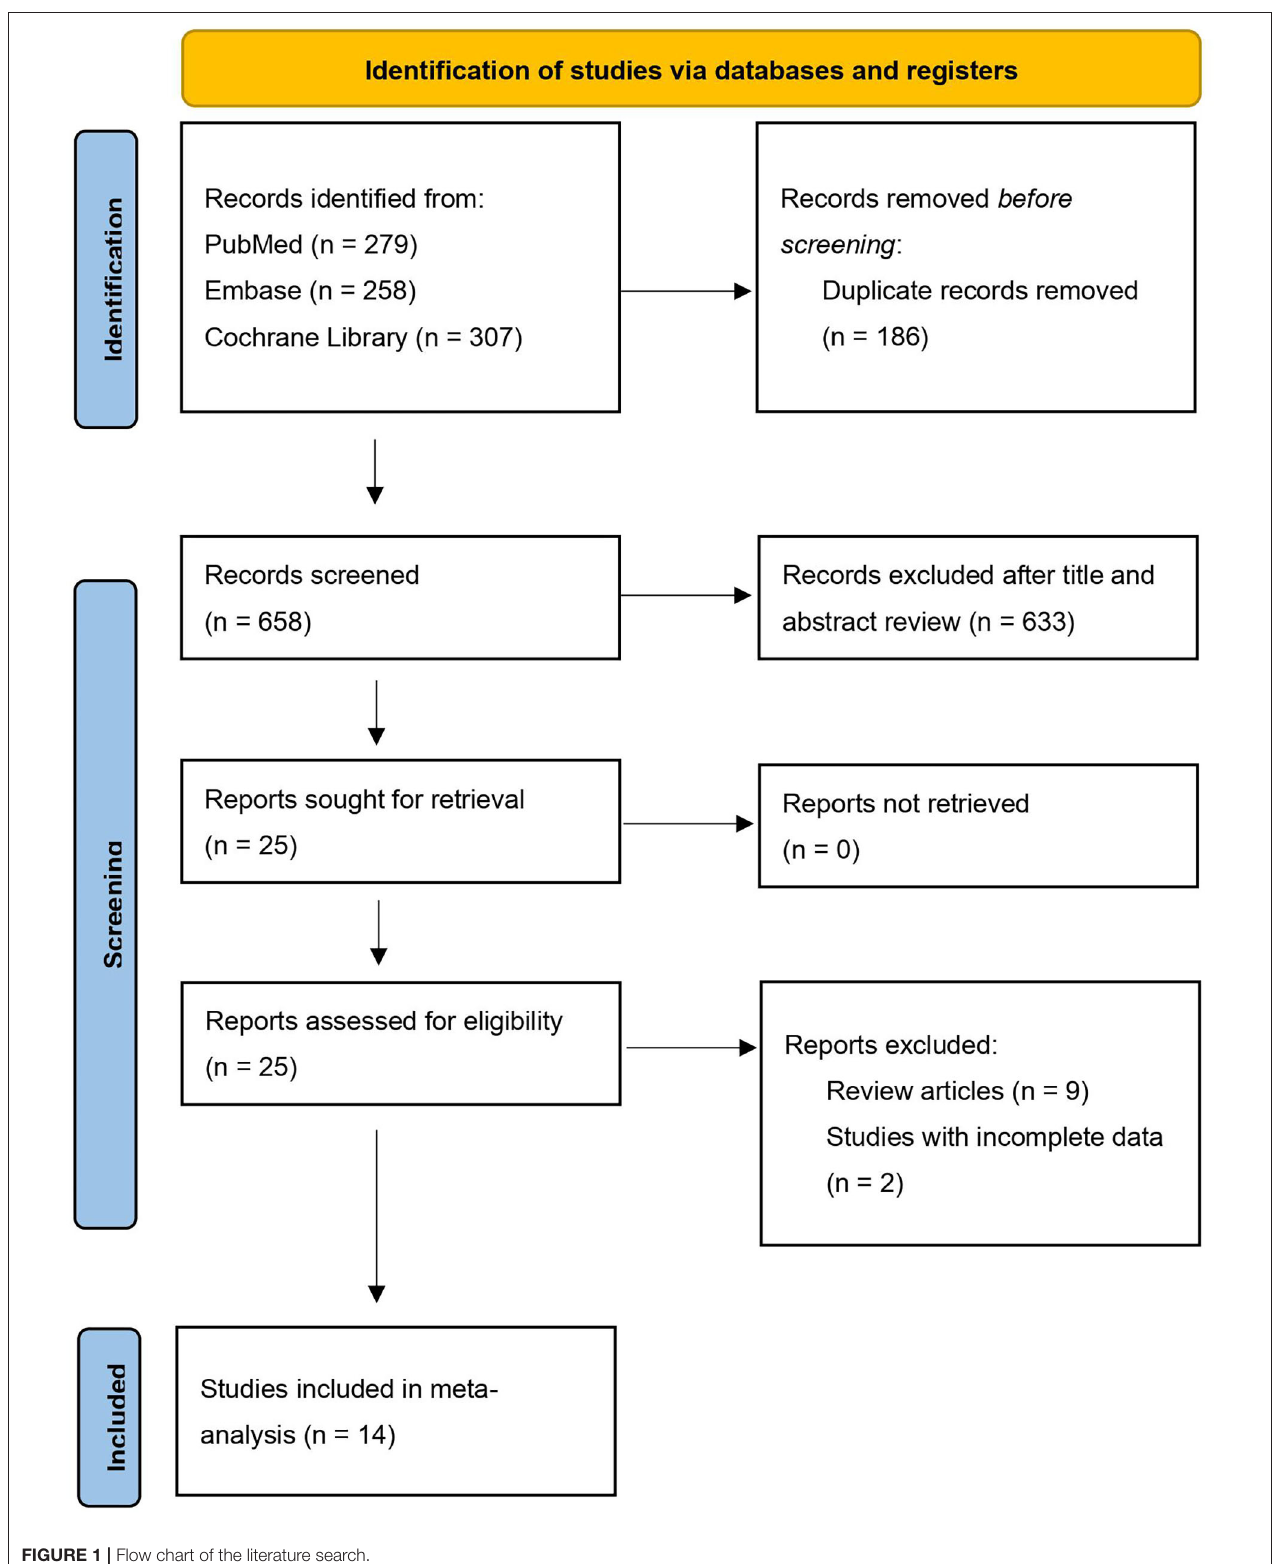
FIGURE 1 | Flow chart of the literature